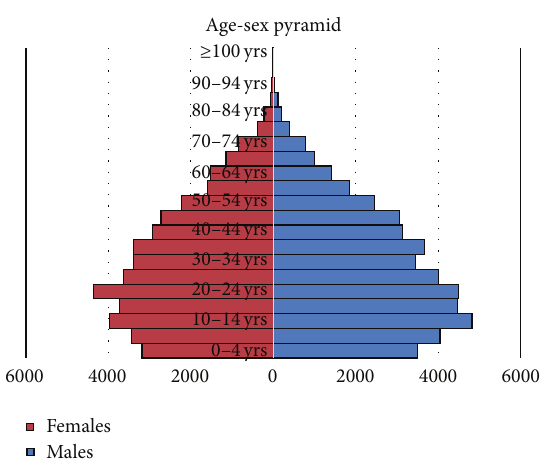
Figure 1: Population pyramid for the study